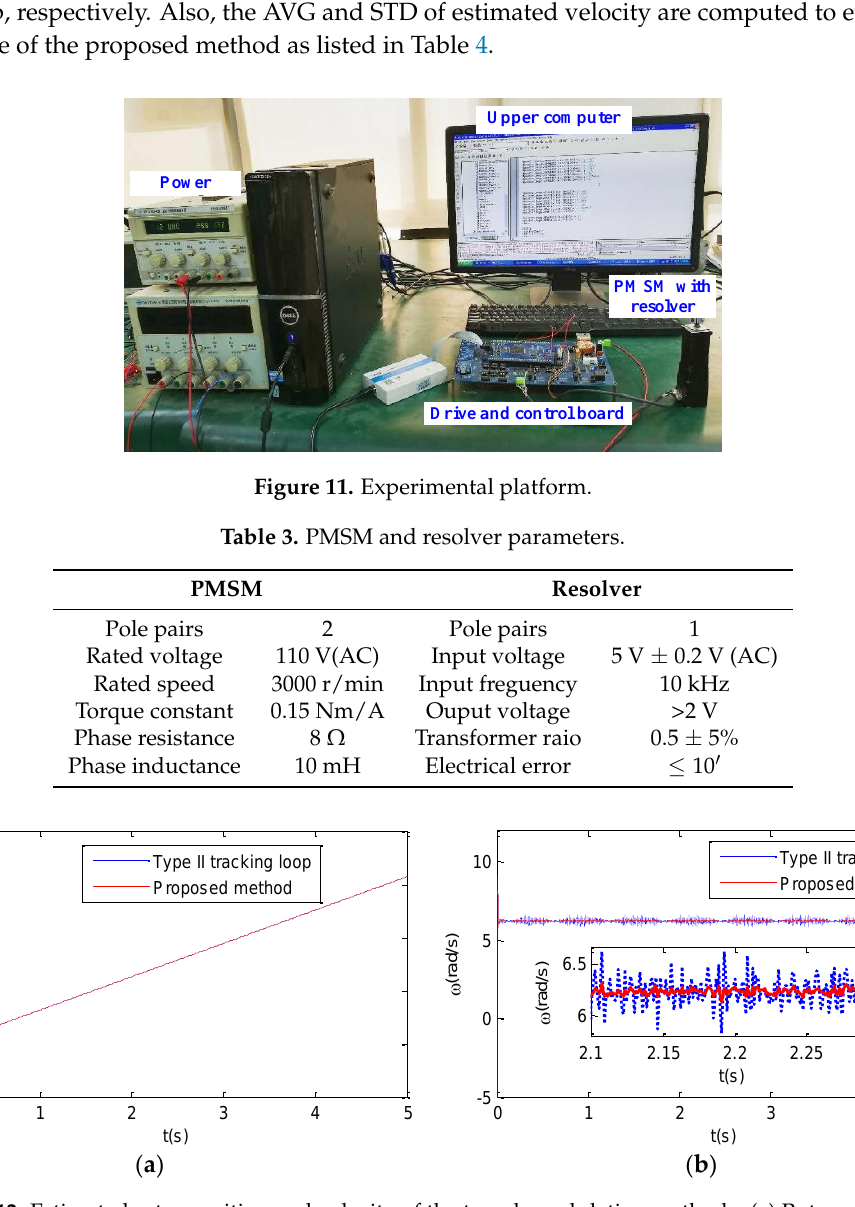
Figure 12. Estimated rotor position and velocity of the two demodulation methods. ( a ) Rotor position estimates; ( b ) rotor velocity estimates.